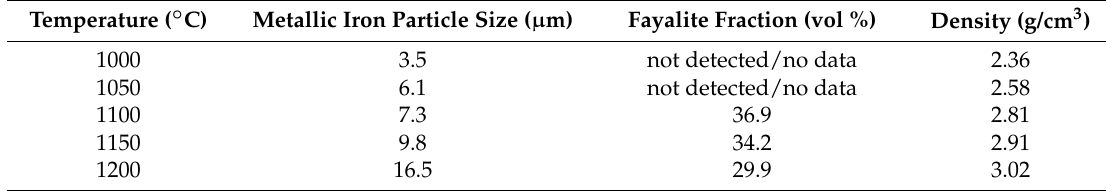
Figure 7. SEM images of the reduced pellets (at 30 min): ( a ) 1000 ◦ C, ( b ) 1050 ◦ C, ( c ) 1100 ◦ C, ( d ) 1150 ◦ C, and ( e ) 1200 ◦ C. Table 2. Summary of some properties of the final reduced